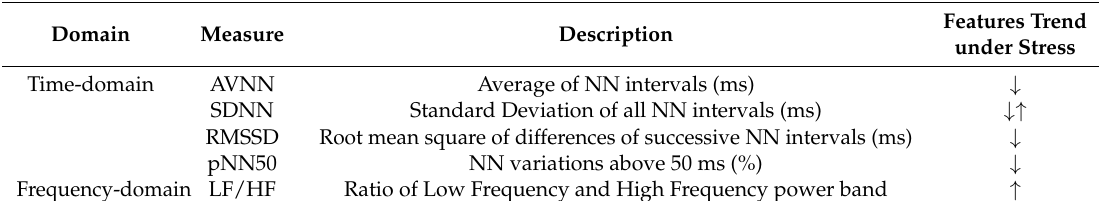
Features Trend under Stress